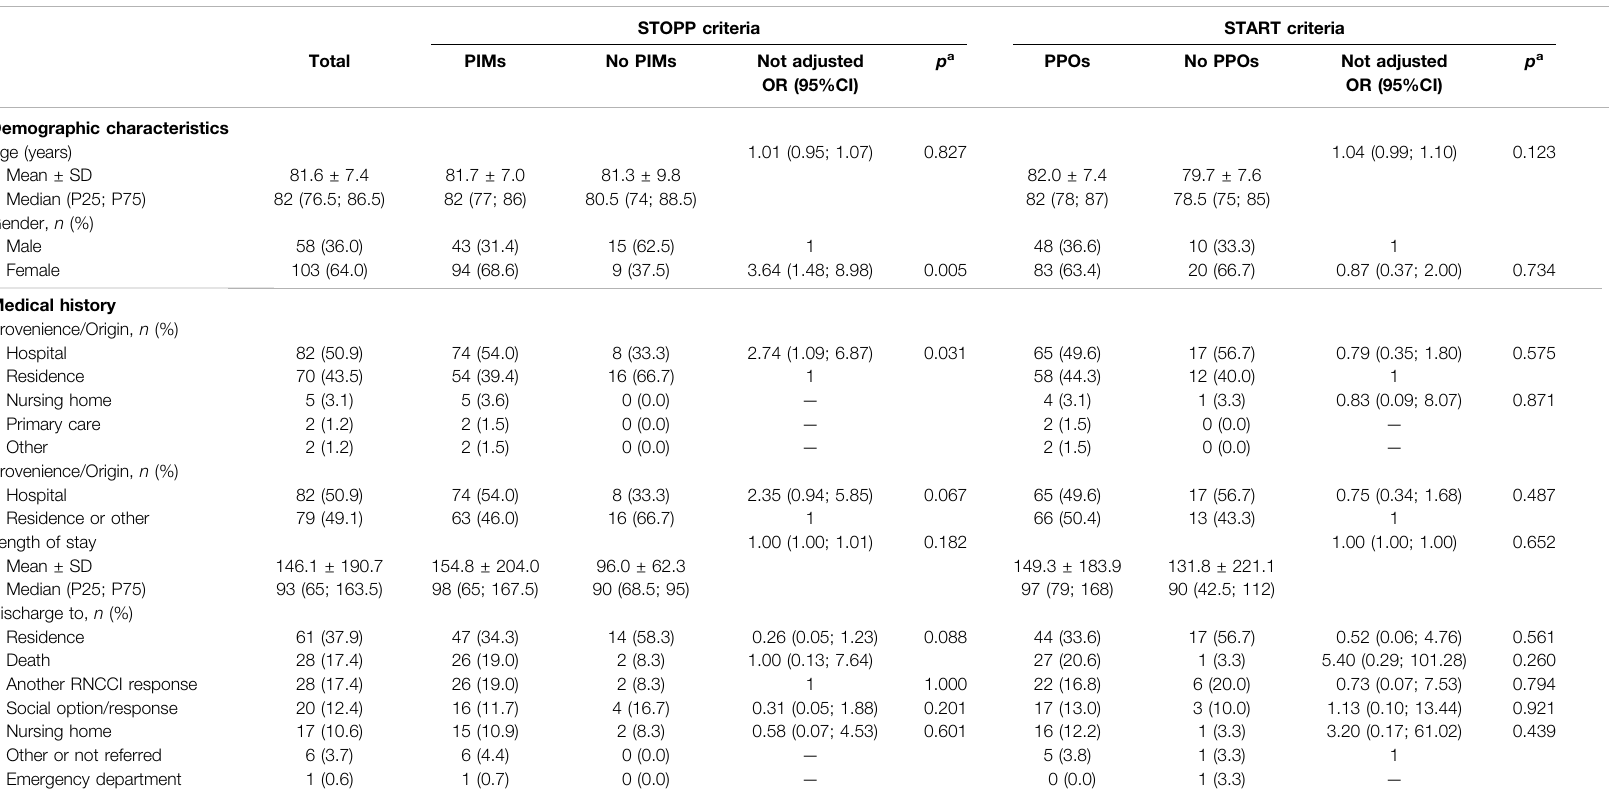
TABLE 1 | Demographic characteristics and medical history of study population ( N (cid:1) 161) that received post-acute care and long-term care in Units for Integrated Continuous Care ( Unidades de Cuidados Continuados , UCCI) inserted in the Portuguese National Network for Long-term Integrated Care ( Rede Nacional de Cuidados Continuados Integrados , RNCCI).